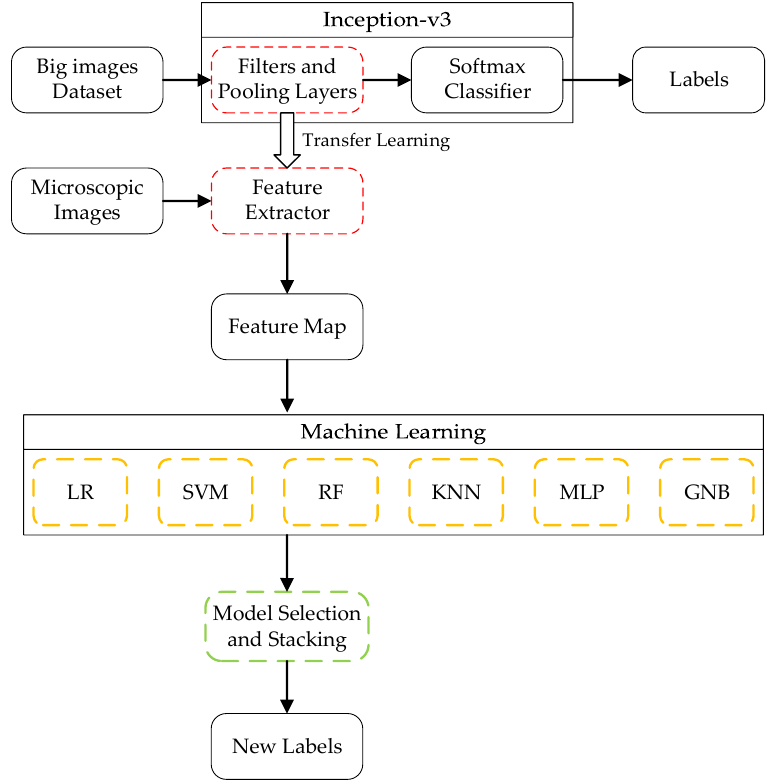
Figure 1. Overall framework for rock-mineral microscopic images identification.